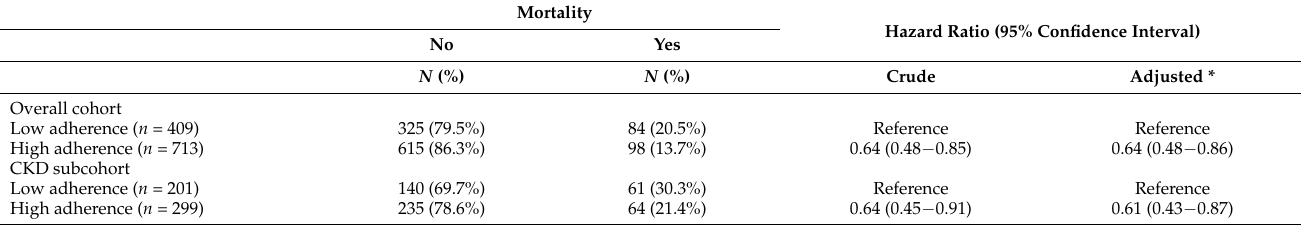
Table 3. Crude and adjusted hazard ratios of all-cause mortality, between high- and low-adherence denosumab users, in the overall cohort and chronic kidney disease subcohort.